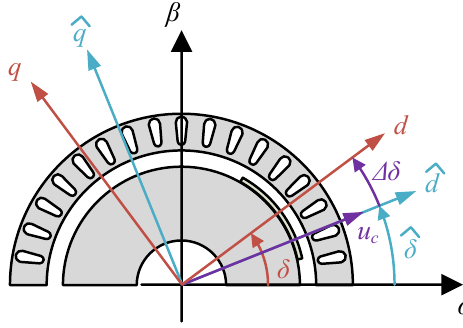
Figure 1. Phasor diagram for the high frequency voltage